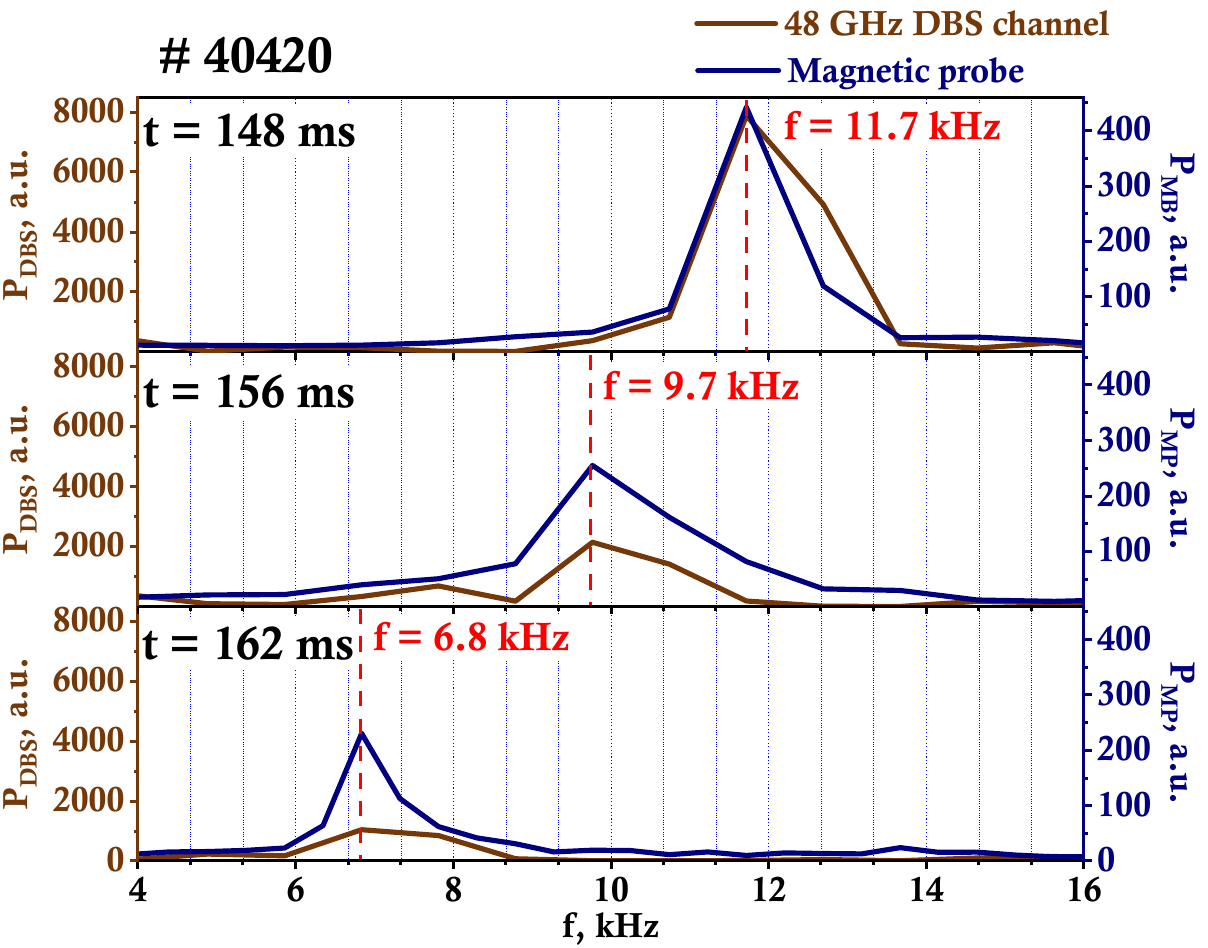
Figure 2. Spectra of the 48 GHz DBS channel phase derivative and magnetic probe signal for discharge #40420.